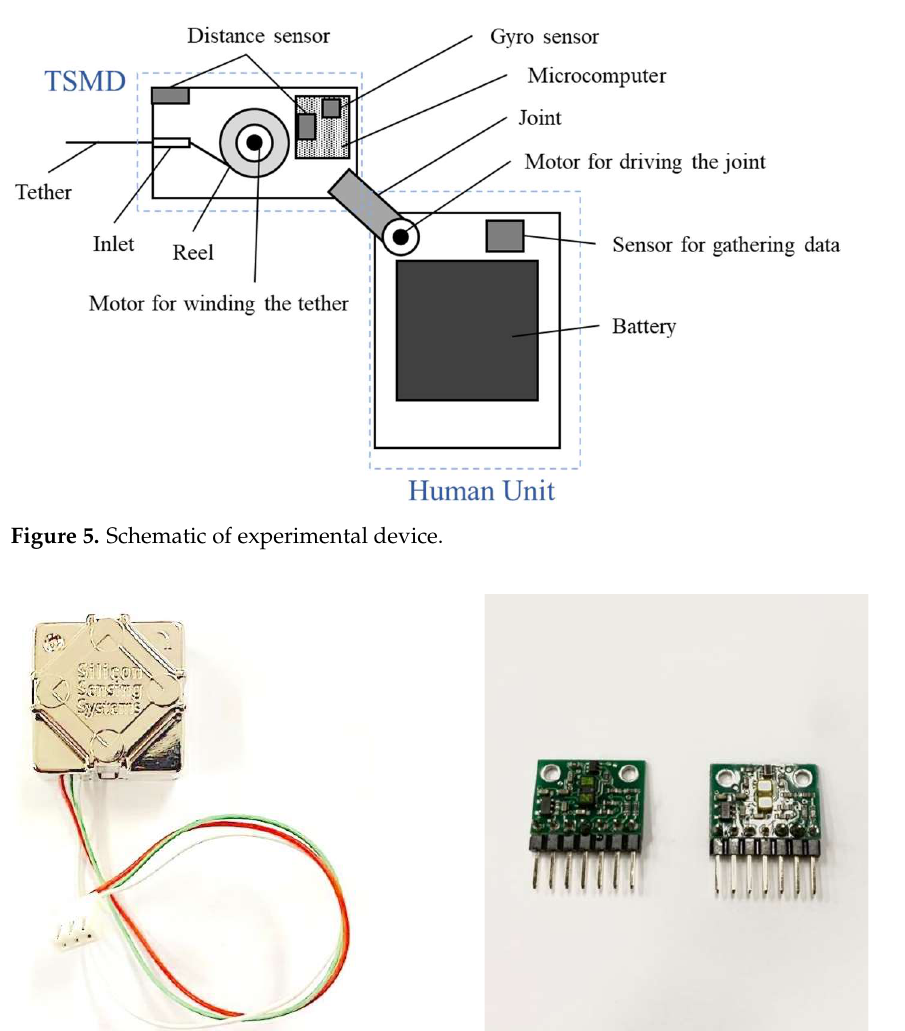
Figure 4. Experimental setup of TSMD.